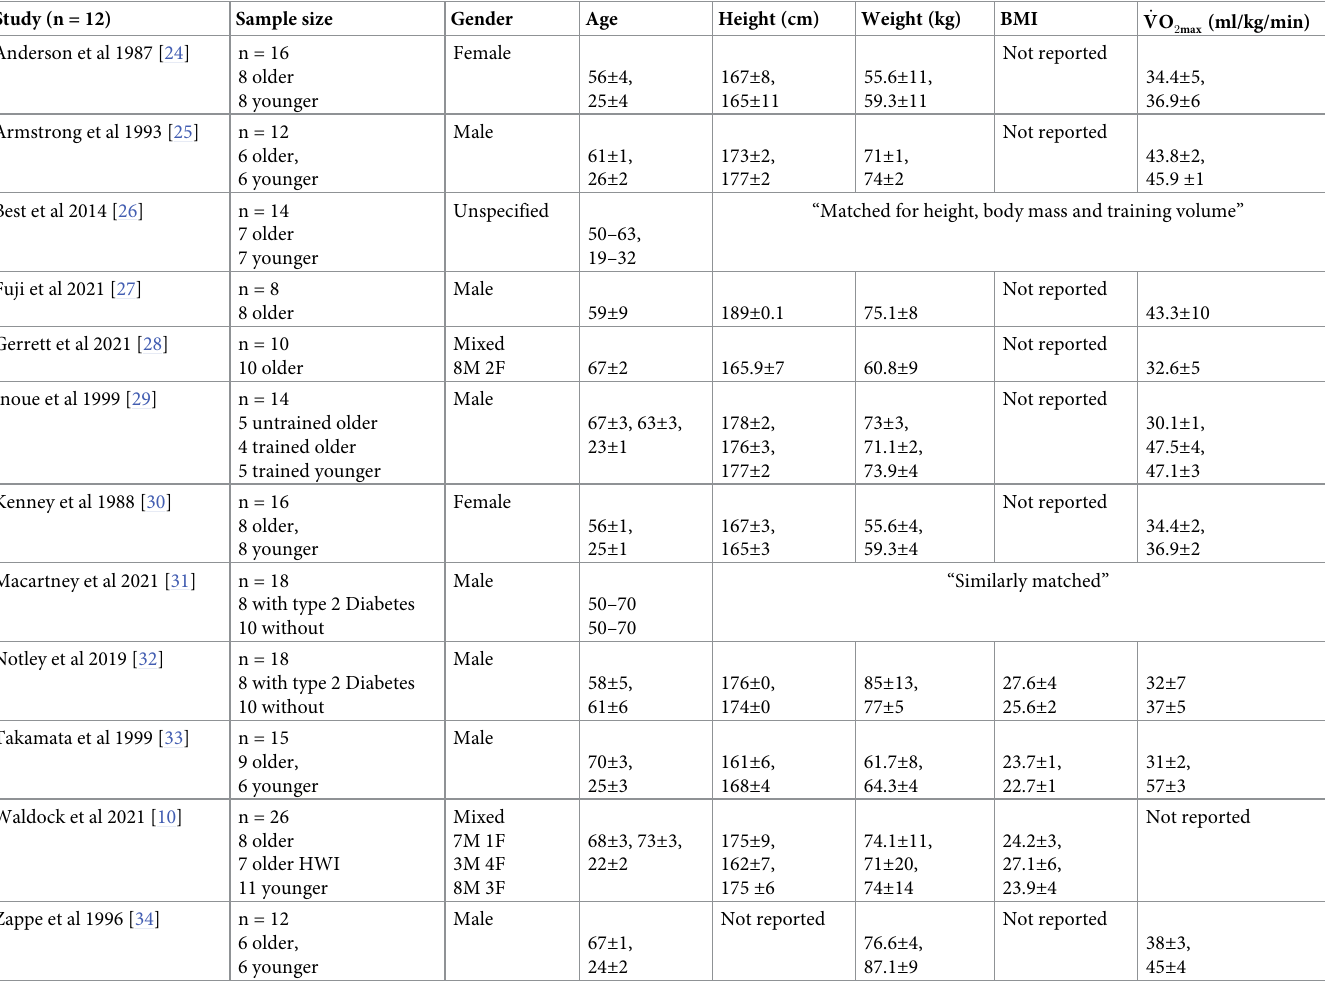
Table 1. Participant